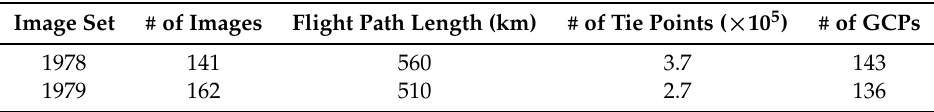
Figure 3. Workflow for generating DEMs from historical imagery. On the left are the steps for manually extracting ground control points (the software used for coregistering is PyBob) and on the right, the SfM photogrammetry processing of the analog aerial images (the images processed using in MicMac and the point clouds are cleaned with CloudCompare). The orange shapes represent manual procedures; the teal shapes are automated steps. Table 1. Attributes of the 1978 and 1979 image sets. A list of the aerial images is available in the Supplementary